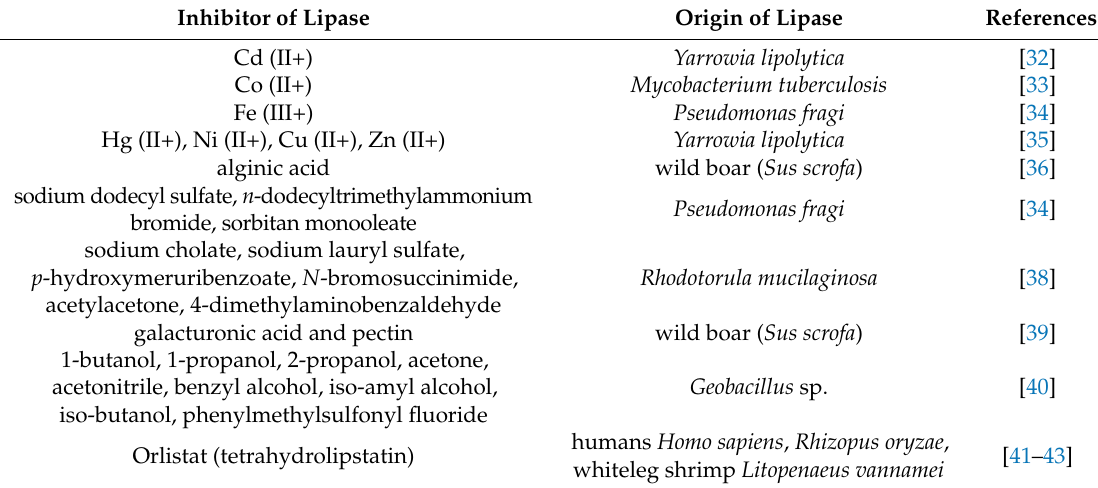
Table 2. The inhibitors of lipases E.C.